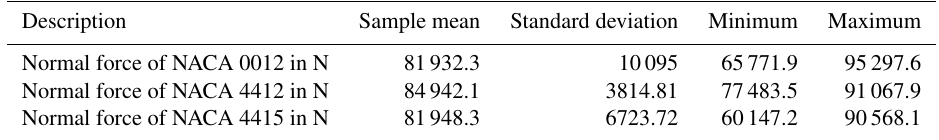
Table 6. List of data variables for normal force